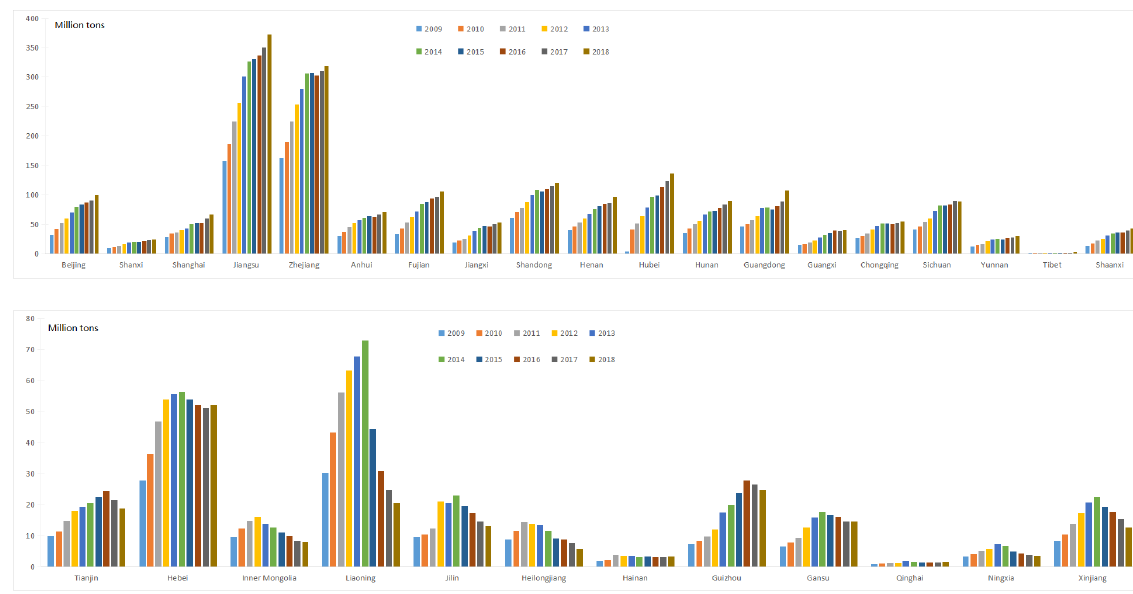
Figure 4. Analysis on the change of construction waste in